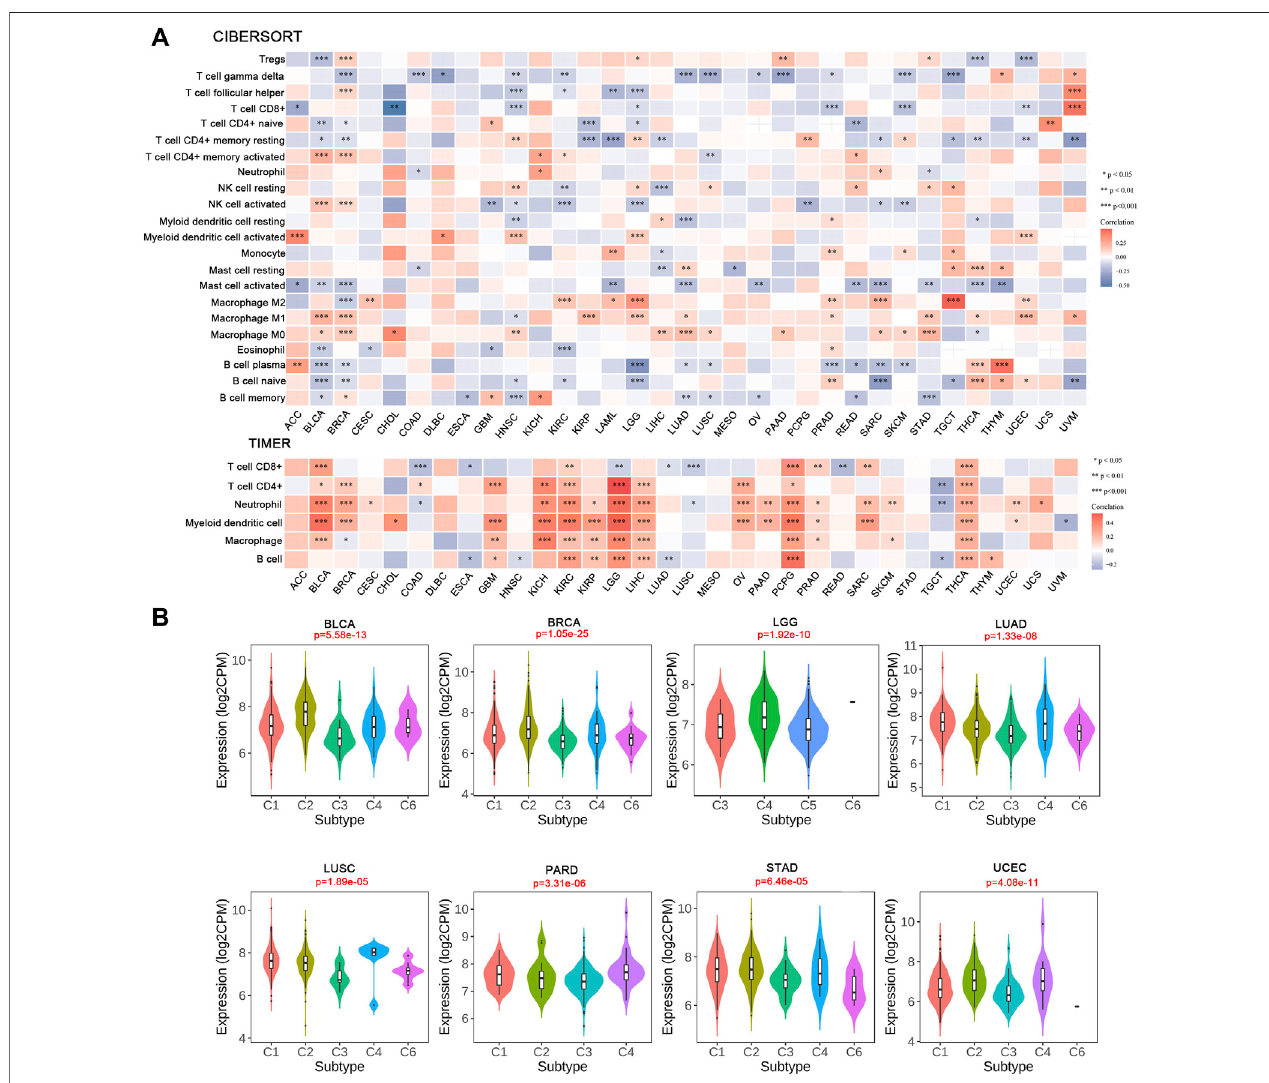
FIGURE 7 | Correlation analysis between IRAK1 expression and tumor-in fi ltrating immune cells. (A) Correlation analysis of IRAK1 mRNA expression with different immune cells from TCGA database by CIBERSORT and TIMER. (B) The relationship between IRAK1 expression in pan-cancer immune subtypes. C1 (wound healing); C2(IFN-gamma dominant); C3 (in fl ammatory); C4 (lymphocyte depleted); C5 (immunologically quiet); C6 (TGF-b